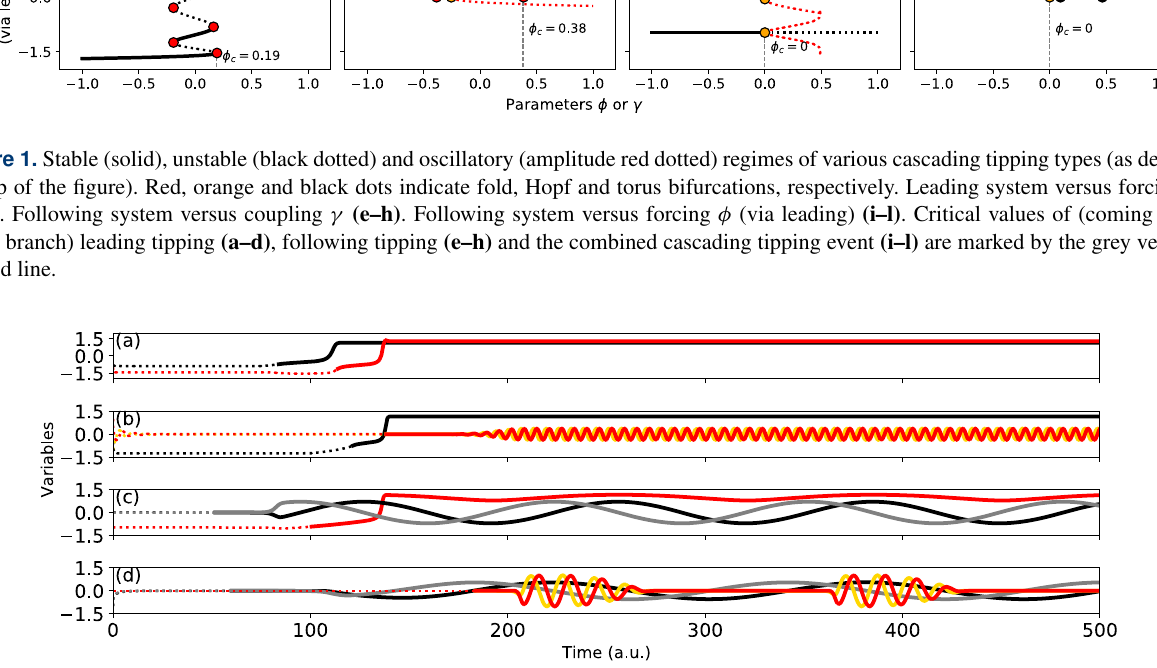
Figure 2. Example simulations for each cascading event type: the double-fold cascade (a) , the fold–Hopf cascade (b) , the Hopf–fold cas- cade (c) and the double Hopf cascade (d) . Black and grey lines indicate the leading systems, red and yellow lines indicate the following systems. Dotted lines indicate time before the critical threshold in the forcing φ ( t ) (black/grey) or coupling κ ( x ) (red/yellow) is reached, solid lines indicate the time after this. Parameter values for the modelled systems are given in Table